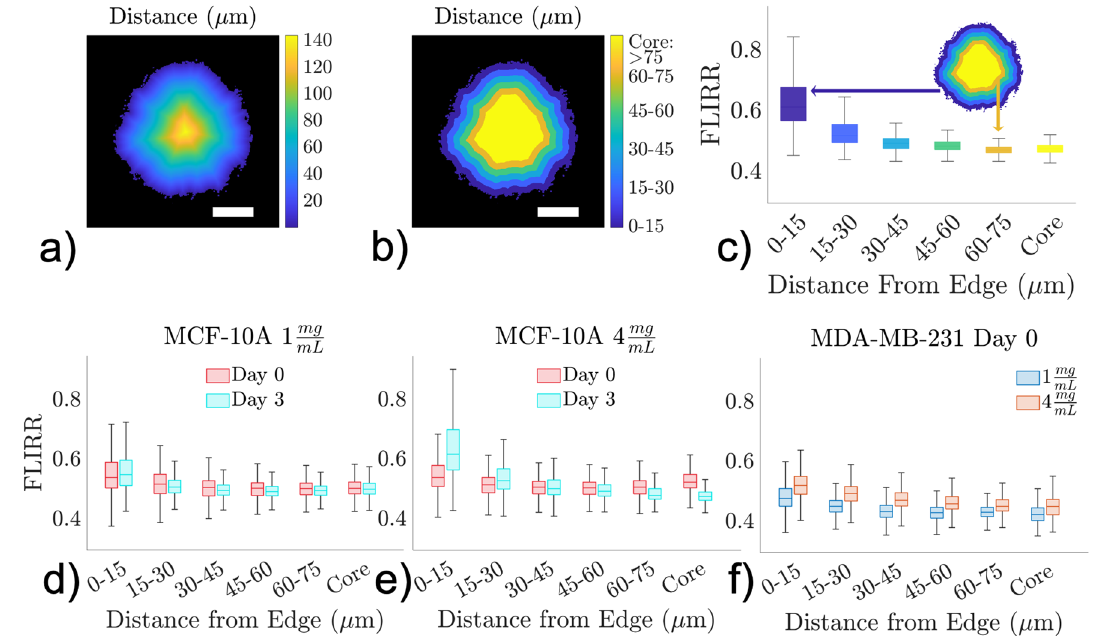
Figure 4. FLIRR values vs distances from the edge. ( a ) Map of Euclidian Distance transform where each pixel’s value represents distance to the nearest edge pixel. ( b ) Discretized distance from the edge map with each color representing a 15um step size. Values greater than 75um are considered as the core. Scale bars (white) indicate 100 µm. ( c ) Representative example of FLIRR vs Distance from the edge plot. For each discretized distance in ( b ) the FLIRR values for those pixels are displayed as a boxplot. Pooled FLIRR vs Distance from the edge for MCF-10A are shown for ( d ) 1 mg/ml and ( e ) 4 mg/ml with Day 0 (red) and Day 3 (turquoise). ( f ) Pooled FLIRR vs Distance from the edge for MDA-MB-231 at Day 0 with 1 mg/ml (blue) and 4 mg/ml (orange). All MCF-10A spheroids and the MDA-MB-231 spheroids at Day 0 displayed enhanced FLIRR values closer to the edge relative to the core with the MCF-10A spheroids on Day 3 at 4 mg/ml displaying the most prominent a metabolic shift in the 3D breast cancer spheroids 4T07 and 4T1 towards increased glucose metabolism and decreased oxygen consumption rate in the tricarboxylic acid (TCA) cycle 48 . MB-231 spheroids have lower FLIRR values at Day 0 compared to MCF-10A spheroids, which may be indicative of increased glycolysis, as previously observed through significantly increased lactate production, and decreased mitochondria reduction activity 49 . A low overlap index (~ 0.4) on Day 0 comparing MDA-MB-231 samples with